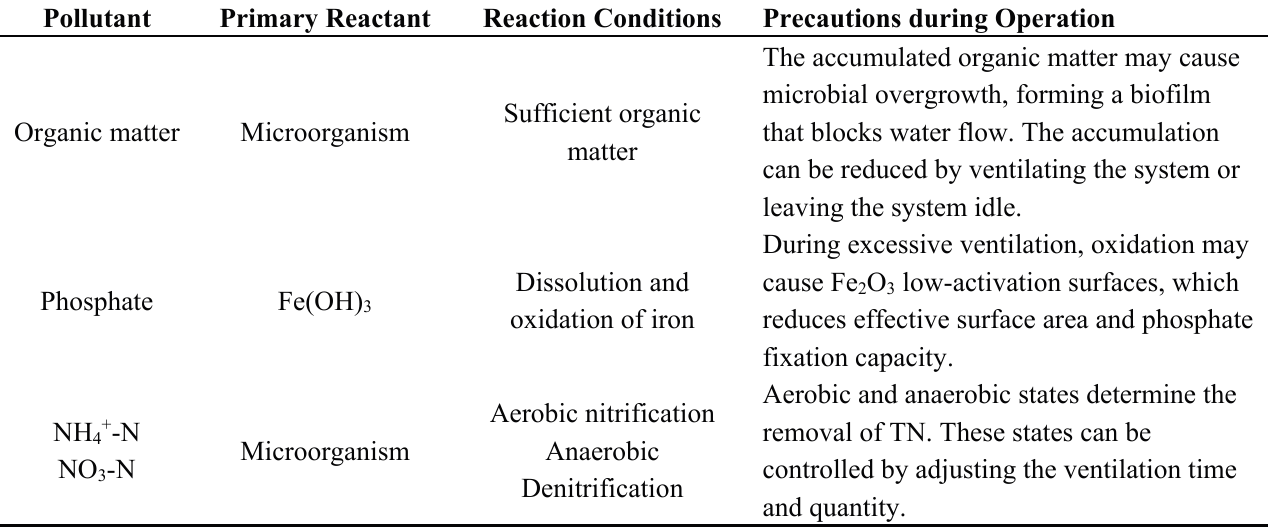
Table 1. Removal characteristics of organic matter, phosphate, NH 4+ -N, and NO 3 -N in the MSL